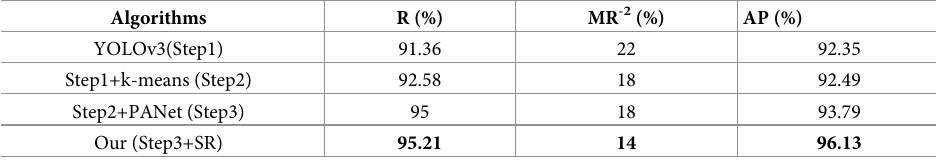
Table 6. Specific index values of three networks.